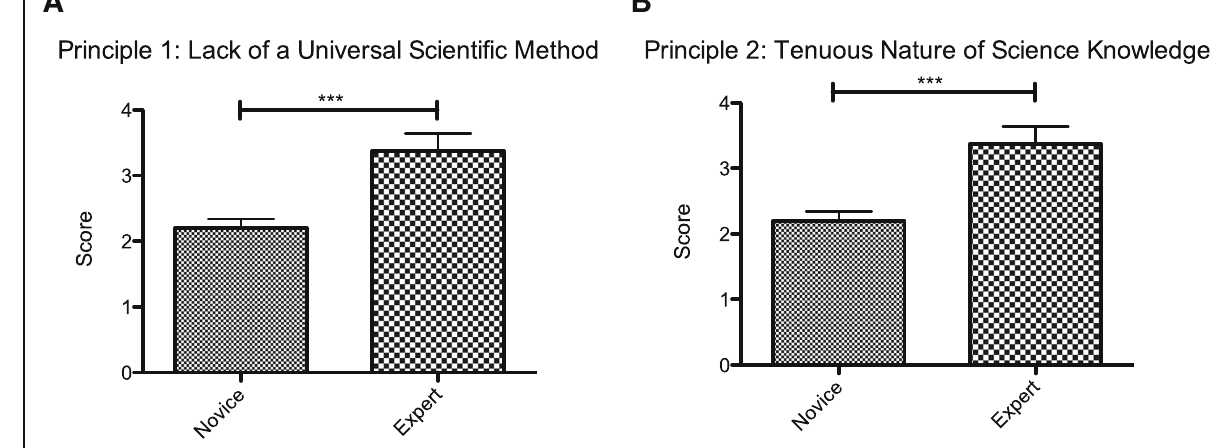
Fig. 2 Experts performed better than novices on a pre-test assessment of their NOS knowledge on both principle 1, lack of a universal scientific method ( a ) and principle 2, tenuous nature of science knowledge ( b